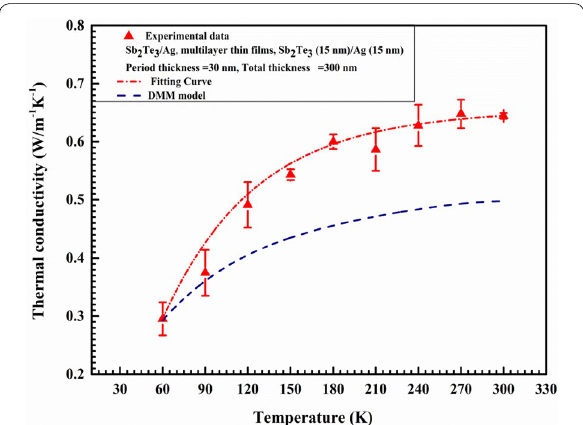
where c 1, j and c 2, j are the group velocities of mode j, ℏ